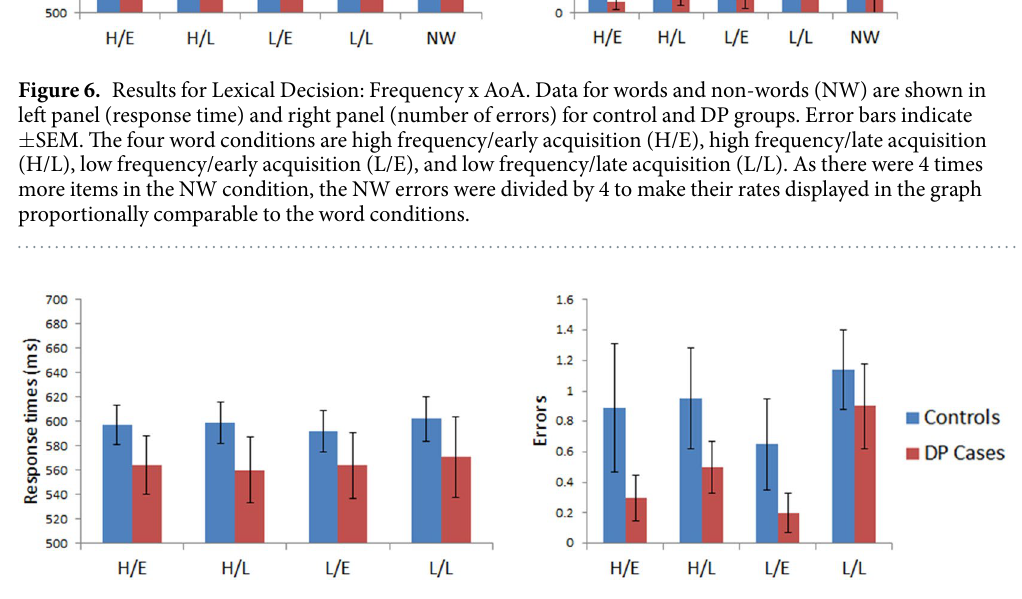
Figure 7. Results for Reading Aloud: Frequency x AoA. Data are shown in left panel (response time) and right panel (number of errors) for control and DP groups. Error bars indicate ± SEM. The four conditions are words of high frequency/early acquisition (H/E), high frequency/late acquisition (H/L), low frequency/early acquisition (L/E), and low frequency/late acquisition